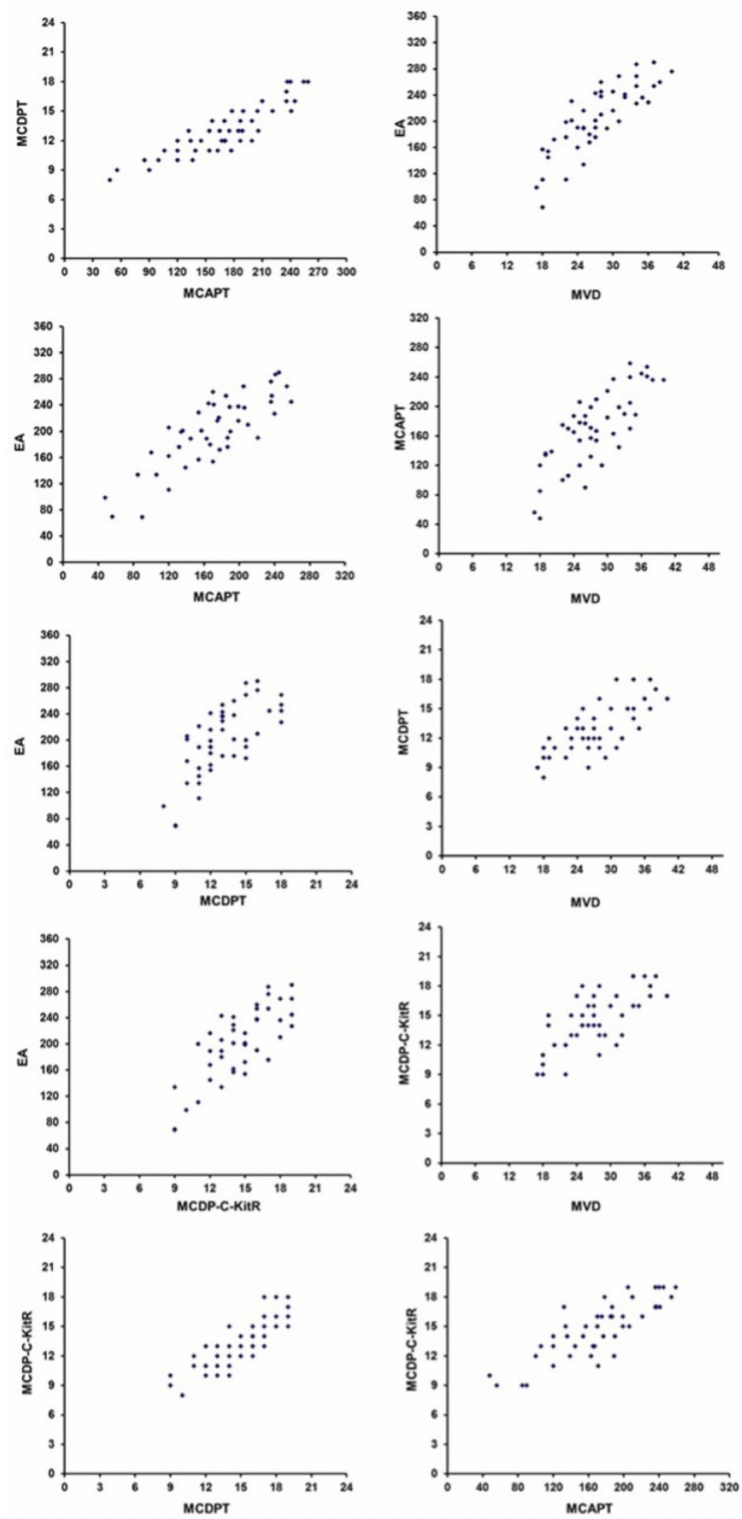
Figure 8. Correlations by Pearson analysis between MCDPT and MCAPT ( r = 0.85, p = 0.01), MVD and EA ( r = 0.82, p = 0.01), EA and MCAPT ( r = 0.66, p = 0.03), MCAPT and MVD ( r = 0.76, p = 0.02), EA and MCDPT ( r = 0.69, p = 0.03), MCDPT and MVD ( r = 0.72, p = 0.02), EA and MCD-c-KitR ( r = 0.73, p = 0.02), MCDP-c-KitR and MVD (r = 0.74, p = 0.02), MCDP-c-KitR and MCDPT (r = 0.87, p = 0.01) and MCDP-c-KitR and MCAPT ( r = 0.81, p =